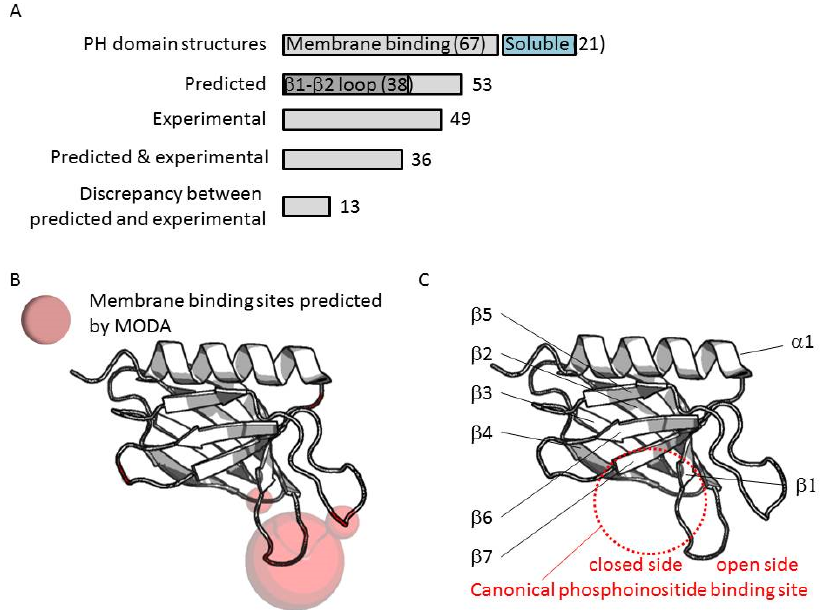
Figure 4. ( A ) Recurrent membrane interactions sites predicted by MODA in PH domain structures; ( B ) The volume of the sphere shown on the ribbon structures is proportional to the number of sites identified herein; ( C ) The fold of the PH domain with the variable regions is depicted with the secondary structures